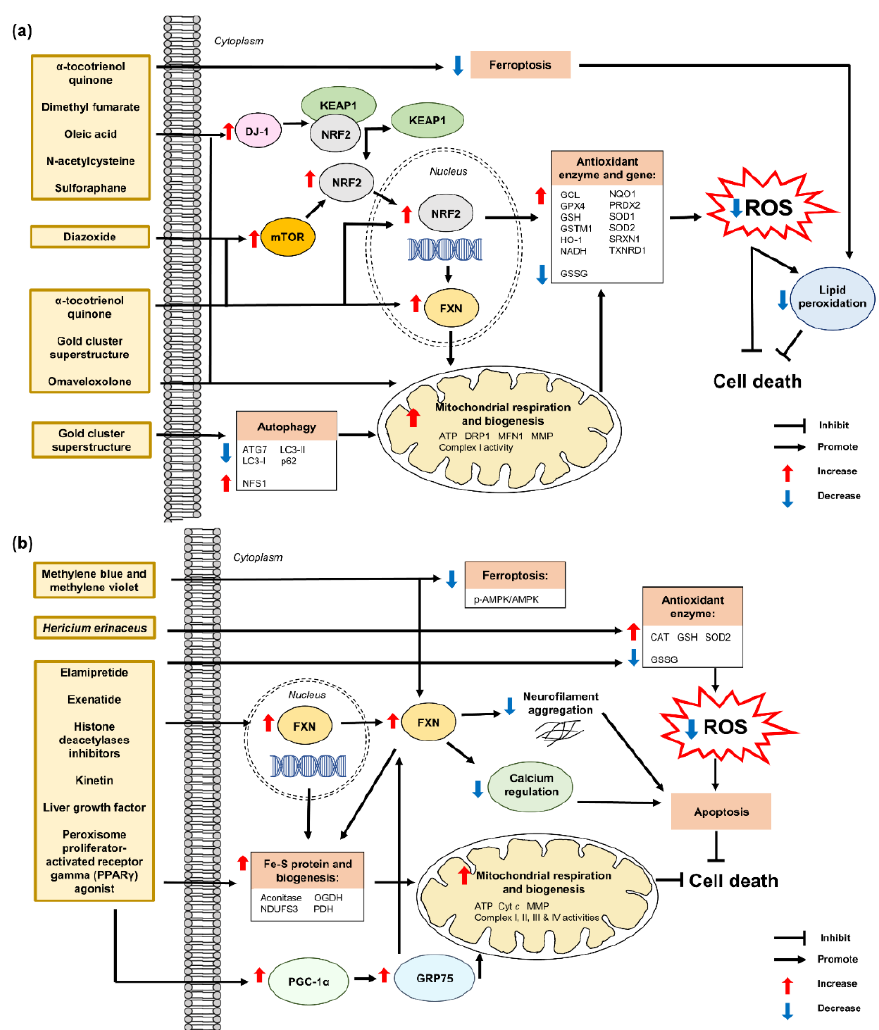
Figure 8. Antioxidant therapies against FRDA. ( a ) Regulation of KEAP1–NRF2 complex, mTOR expression, lipid peroxidation, mitochondrial impairment and autophagy by antioxidant therapies results in the dissociation of KEAP1–NRF2 complex, restoration of mitochondrial respiration and biogenesis, and attenuation of lipid peroxidation. The dissociation of the KEAP1–NRF2 complex leads to the upregulation of downstream targets responsible for increased levels of antioxidant enzyme and gene, and attenuation of ROS production and pro-apoptotic activities. ( b ) Regulation of FXN expression and antioxidant enzymes by antioxidant therapies results in the promotion of FeS clusters biogenesis and restoration of mitochondrial function. Increased protein level of frataxin restores calcium regulation and attenuates neurofilament aggregate formation. The events ultimately lead to the attenuation of ROS production and pro-apoptotic activities. AMPK, AMP-activated protein kinase; ATG7, autophagy related 7; ATP, adenosine triphosphate; CAT, catalase; Cyt c , cytochrome c ; DJ-1, protein deglycase; DRP1, dynamin-related protein 1; FXN, frataxin; GCL, γ -glutamyl cysteine ligase; GPX4, glutathione peroxidase 4; GRP75, glucose-regulated protein 75; GSH, glutathione; GSSG, oxidized glutathione; GSTM1, glutathione S-transferase mu 1; HO-1, heme oxygenase-1; KEAP1, Kelch-like ECH-associated protein 1; LC3, microtubule-associated protein 1A/1B-light chain 3;